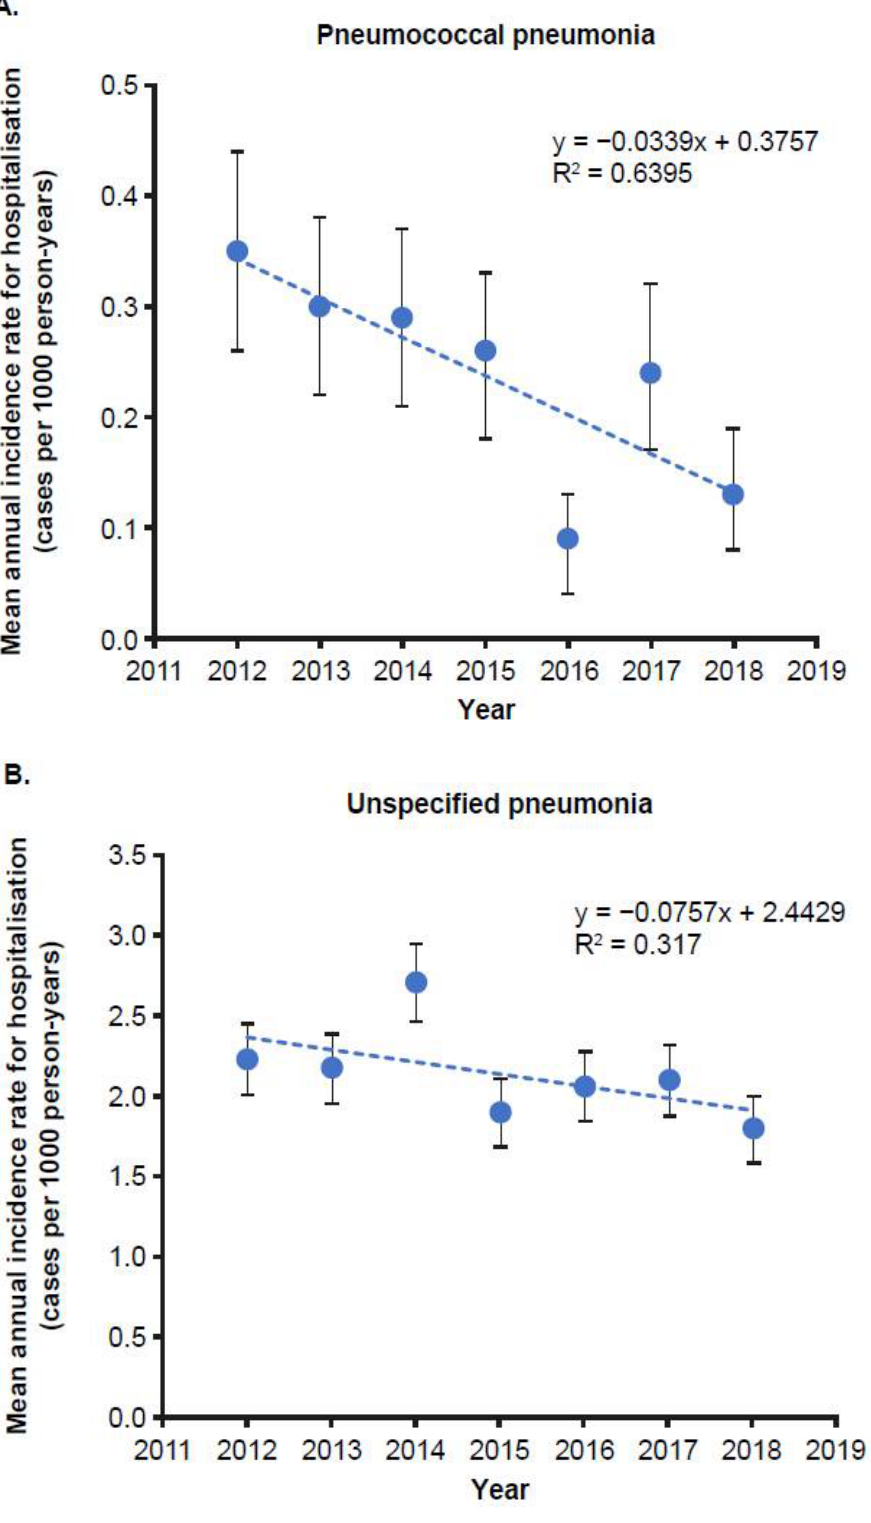
Figure 1. Annual incidence of ( A ) pneumococcal pneumonia and ( B ) unspecified pneumonia hospi- talisation in Liguria, Italy, in children < 15 years of